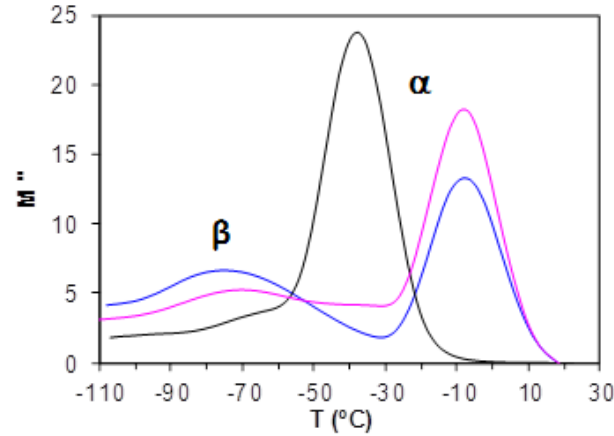
Figure 14. Loss modulus obtained by DMA at10 Hz and for a heating rate of 2 K/min for the three systems studied: epoxy, blue line; HBPEI, black line; uncured ELP, pink line.